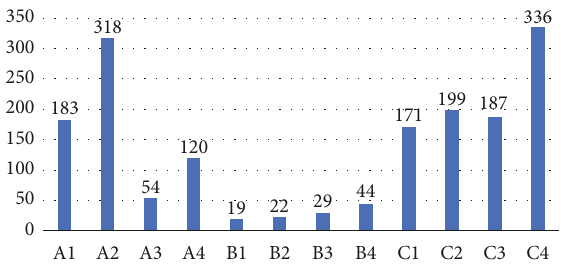
Figure 5: Schematic diagram of the proportion of training data.